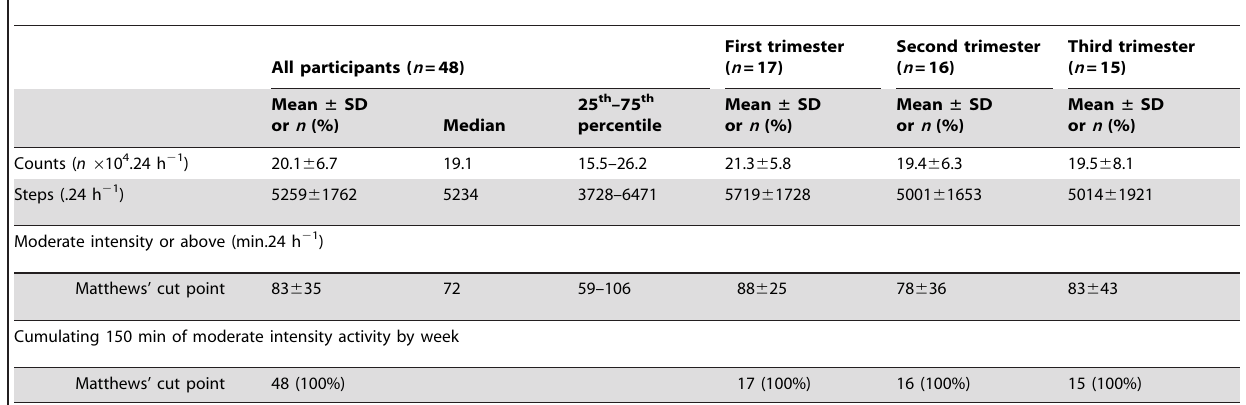
Table 2. Physical activity distribution during pregnancy from Actigraph’s GT1M